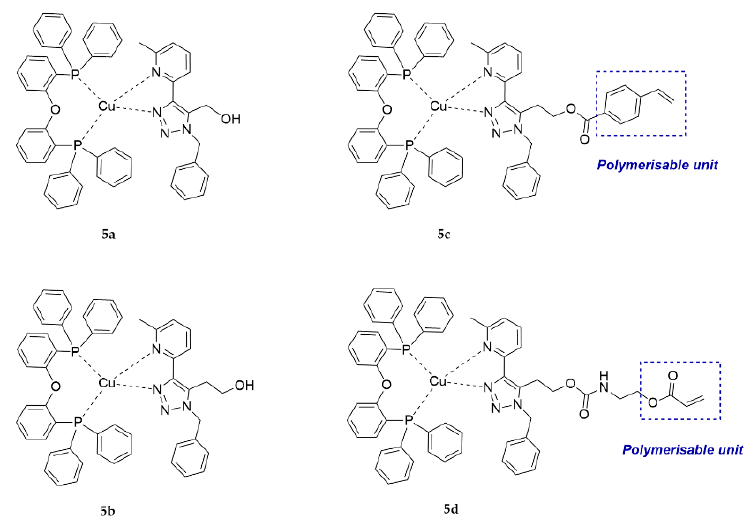
Figure 1. Structures of the copper(I) complexes that were investigated in this work. The structures can be classified as those bearing a hydroxyl group ( 5a , 5b ) or a polymerisable unit ( 5c , 5d ).